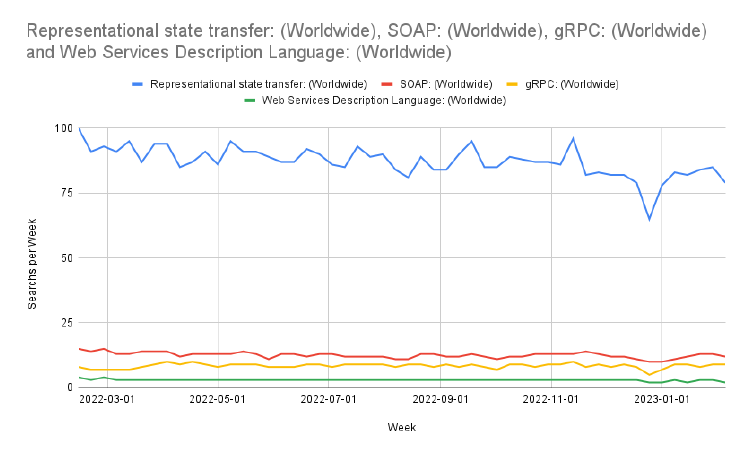
Figure 2. Comparison of REST, SOAP, gRPC, and WSDL searches